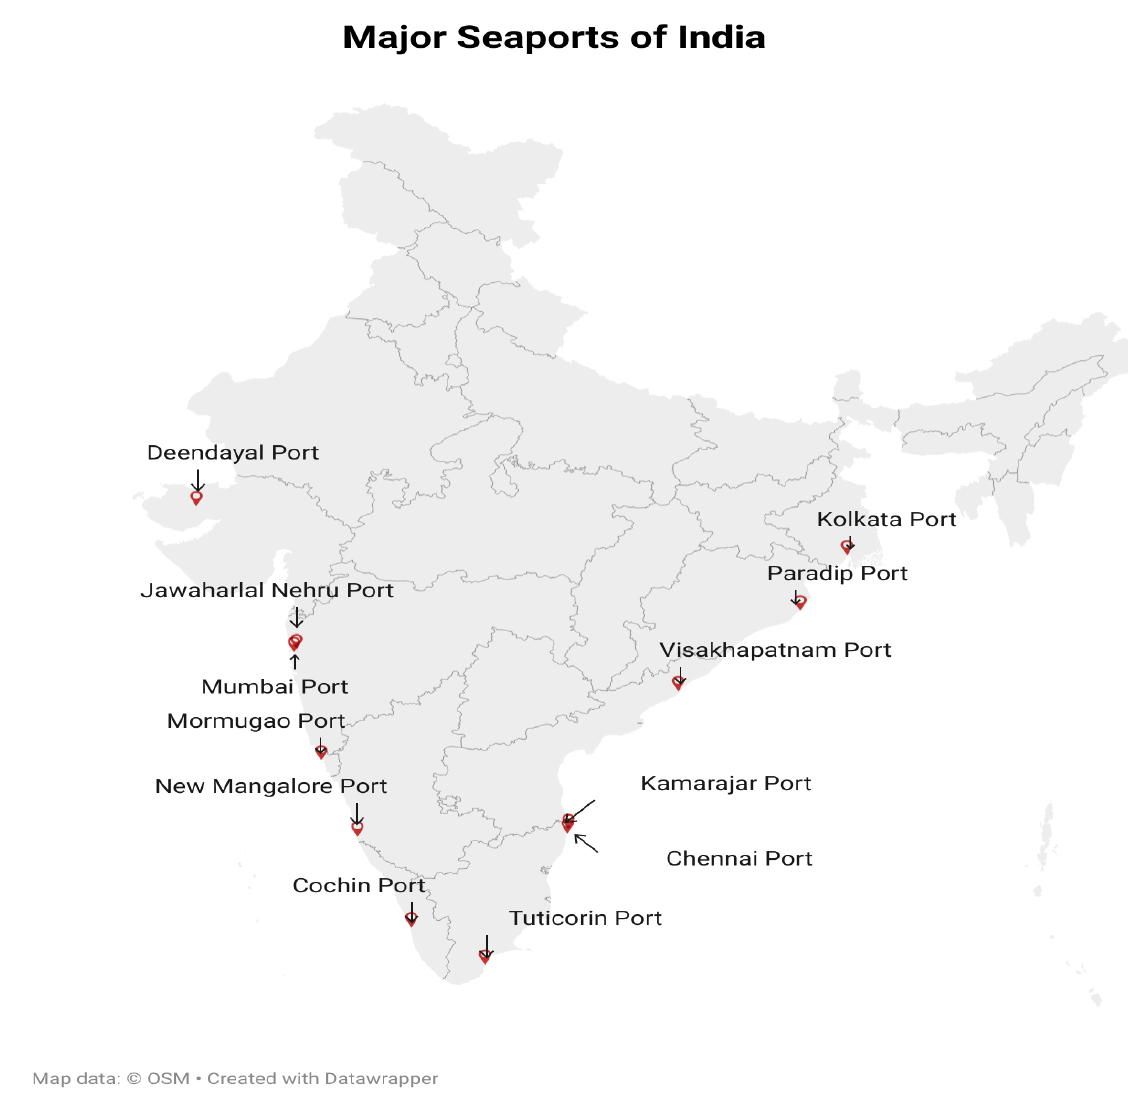
Figure 1: Location of India’s 12 major